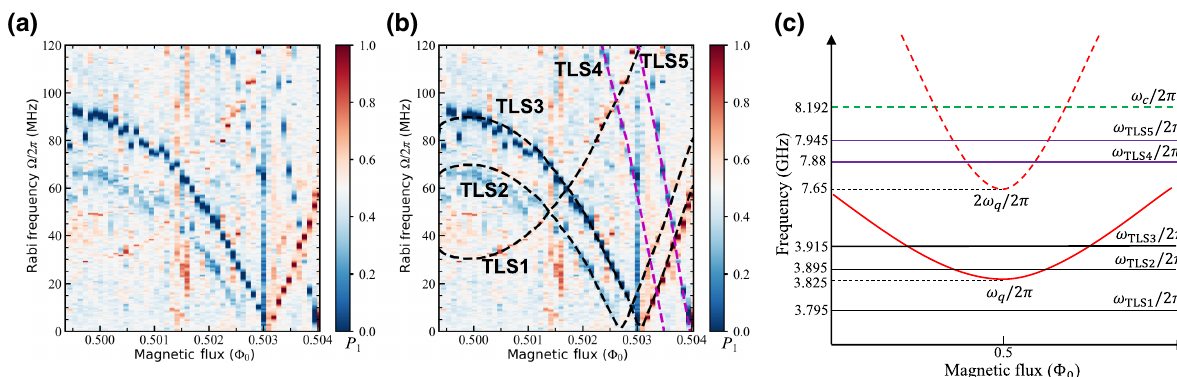
FIG. 4. Experimental demonstration of TLS defect detection using a strong qubit drive. (a) Final exited-state qubit population as a function of the applied magnetic flux and the qubit drive amplitude in Rabi-frequency units. (b) Results of the fitting of the experimental data. Spectral lines TLS1, TLS2, and TLS3 can be fit by Eq. (25) that corresponds to charge-fluctuation TLS defects. Spectral lines TLS4 and TLS5 can be fit by Eq. (29) that corresponds to critical-current-fluctuation TLS defects. (c) Energy level diagram of the system (not to scale). Solid and dashed red lines correspond to the qubit transition frequency ω q and the double value of ω q , respectively. Black and magenta horizontal lines represent charge-fluctuation and critical-current-fluctuation TLS defects, respectively. The dashed green line corresponds to the cavity resonance